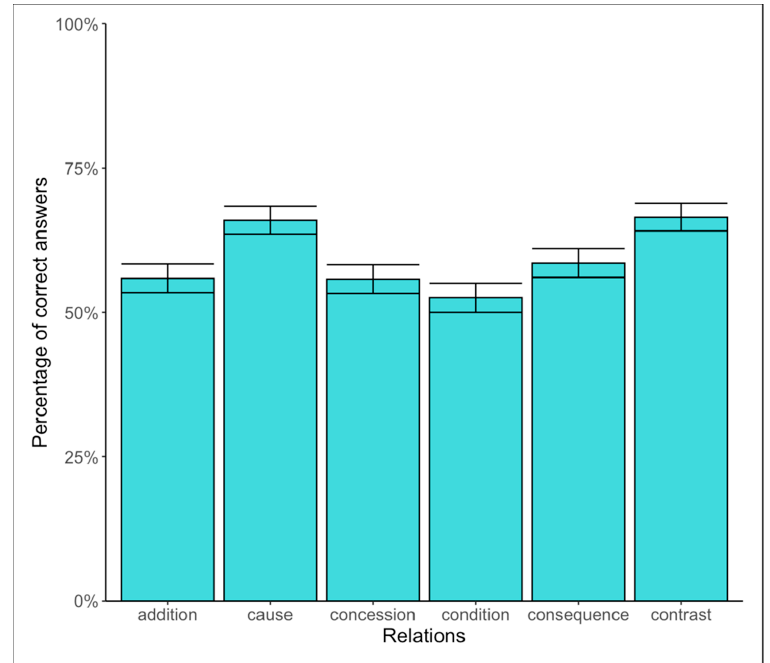
Figure 6. Percentage of correct answers by non-native speakers per relations . Table 8. Non-native speakers, differences between the tested connectives within the relations.